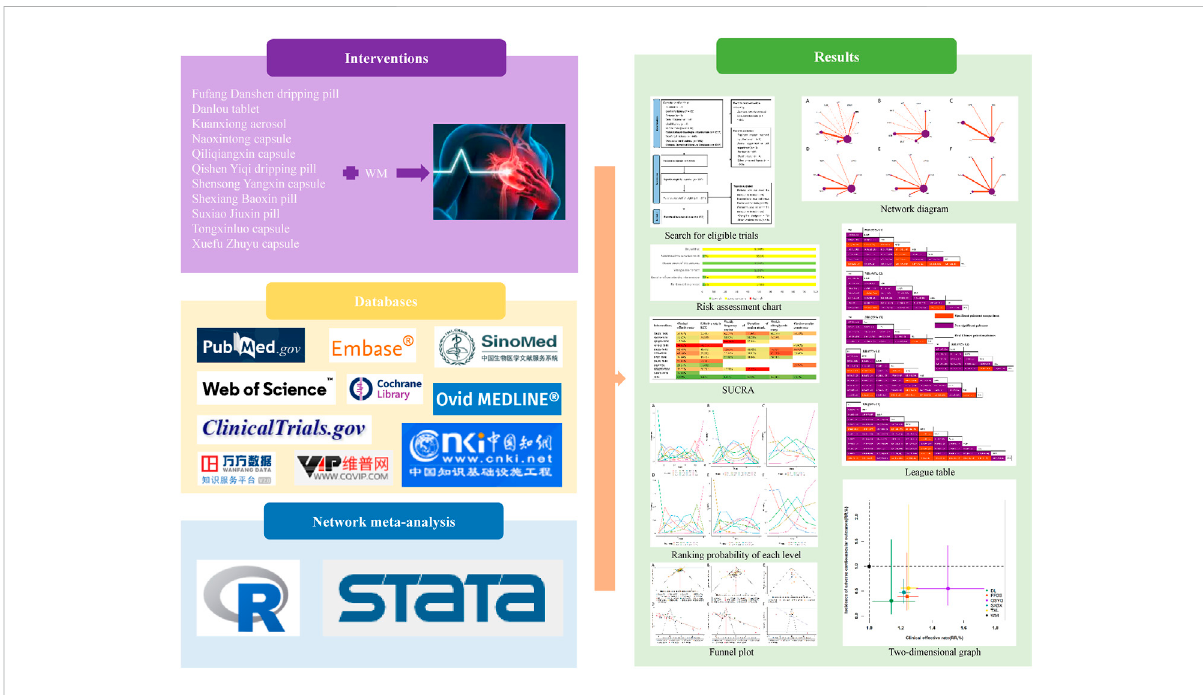
FIGURE 1 Graphical abstract of the network meta-analysis. WM, Western